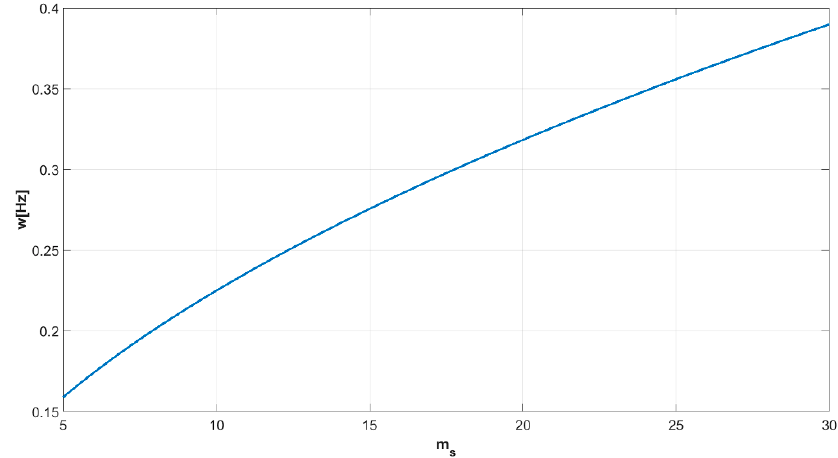
Figure 4. The frequency of inter-area oscillations depending on the synchronizing power coefficient.